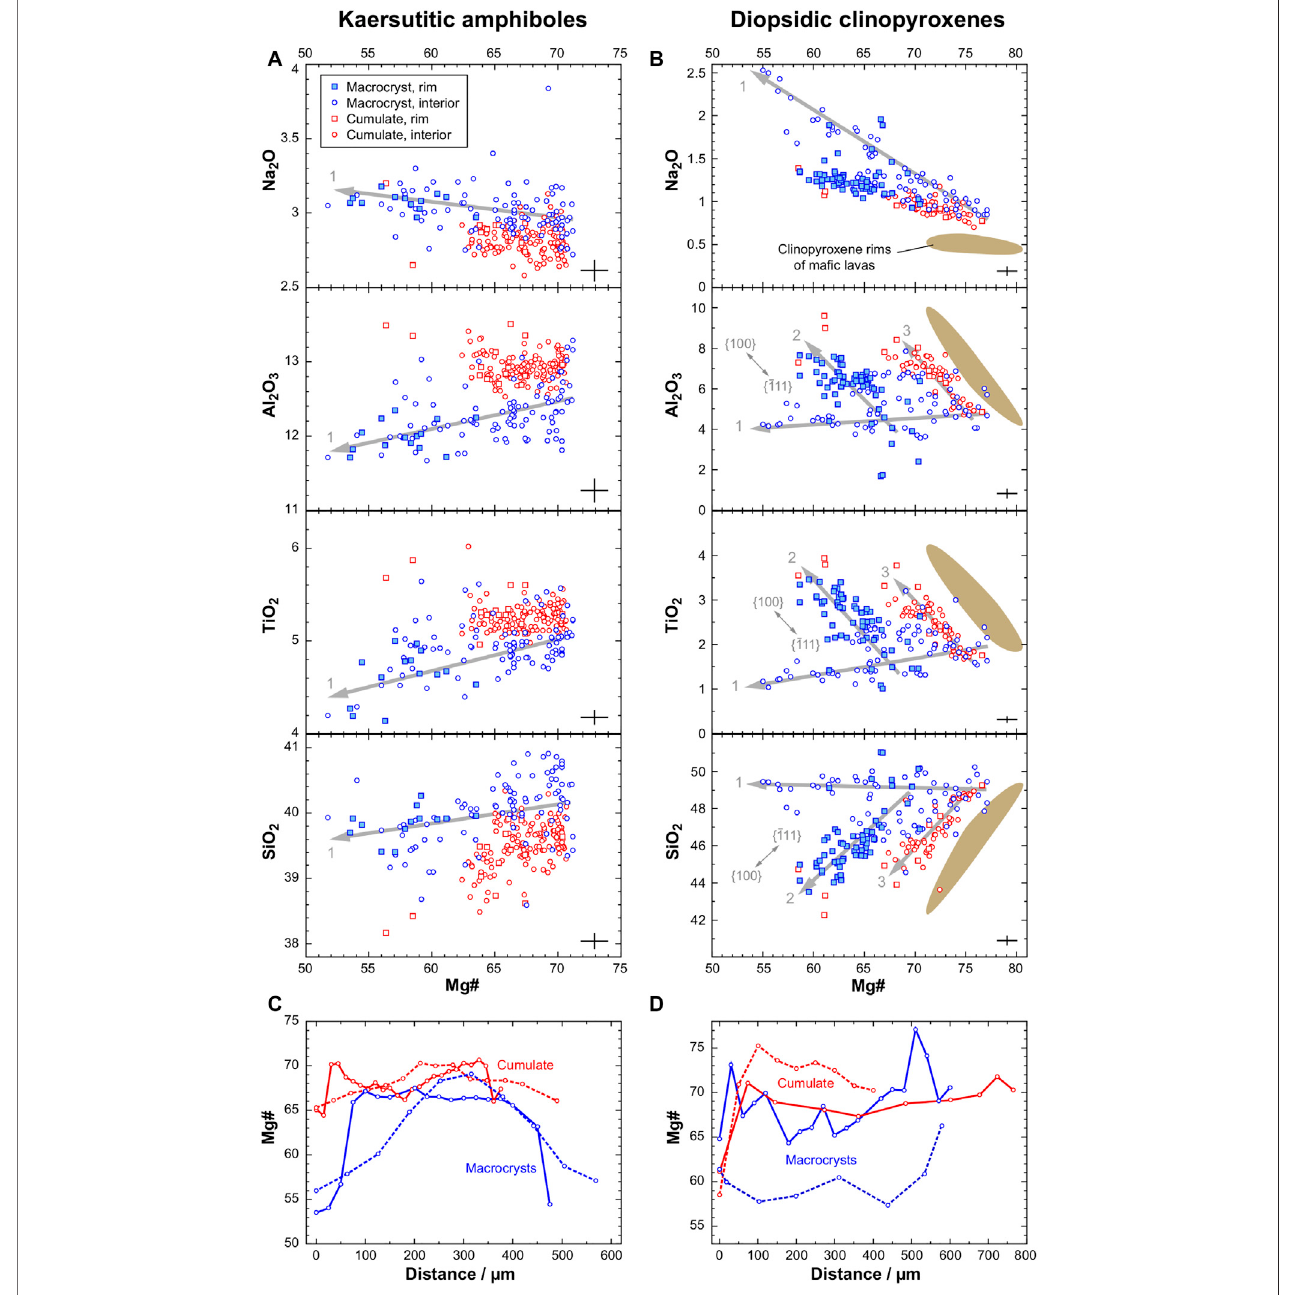
FIGURE 3 | Chemical compositions of (A) kaersutite and (B) diopside macrocrysts in the host tephriphonolite (blue symbols) and in cumulate xenoliths (red symbols) plotted in bivariate diagrams versus Mg#. Analyses at the outermost crystal rims are indicated by squares, those in the inner regions by circles. Brown fi elds outline average compositions of rims of clinopyroxene macrocrysts hosted by ma fi c lavas (basanites and tephrites; Klügel et al., 2000, 2005). Error bars indicate analytical uncertainty (±1 standard deviation) as based on analyses of secondary standards. Cumulate crystals show limited compositional overlap with macrocrysts and a smaller compositional range. Clinopyroxene compositions de fi ne three major trends indicated by thick arrows: trend 1) is interpreted to re fl ect progressive crystal fractionation, whereas trends 2) and 3) show opposite behavior for some elements. These trends are consistent with sector zoning, in which hourglass{ − 111}basalsectorsarehigherinMg#andSiO 2 ,andlowerinAl 2 O 3 andTiO 2 ,than{100}prismsectors(cf.Ubideetal.,2019).Thefractionationtrend1)isalso broadly recognized in kaersutite macrocrysts. (C , D) Compositional pro fi les showing Mg# of selected kaersutite and diopside crystals, respectively.